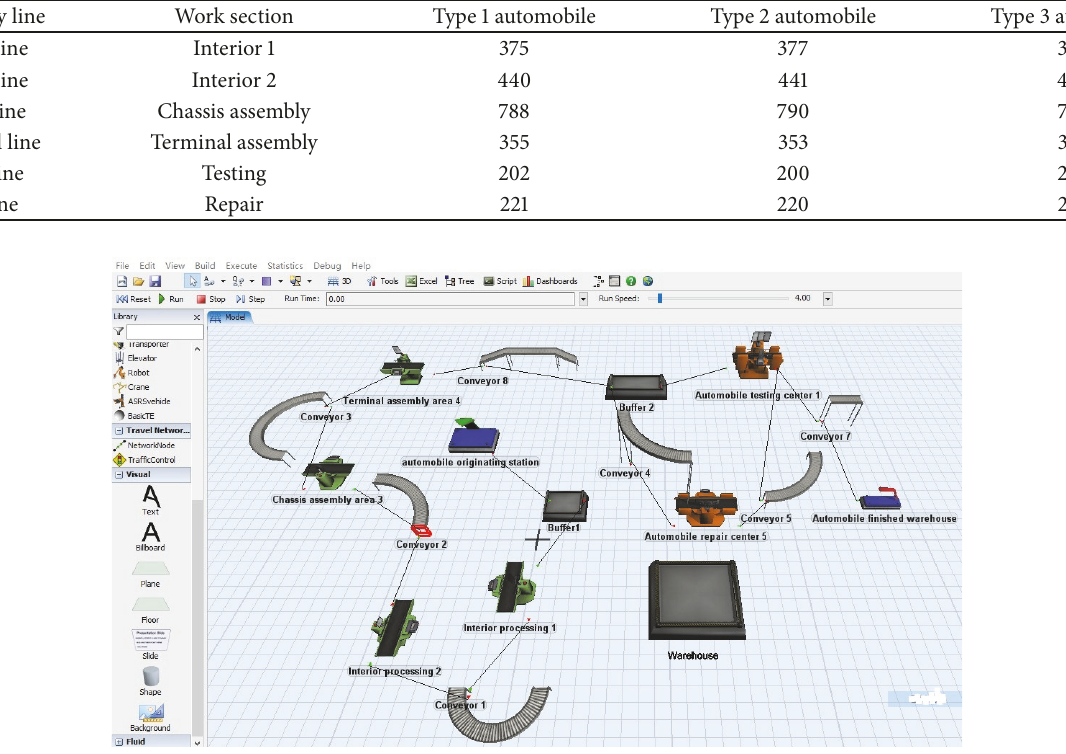
Figure 7: FlexSim software simulation model of automotive